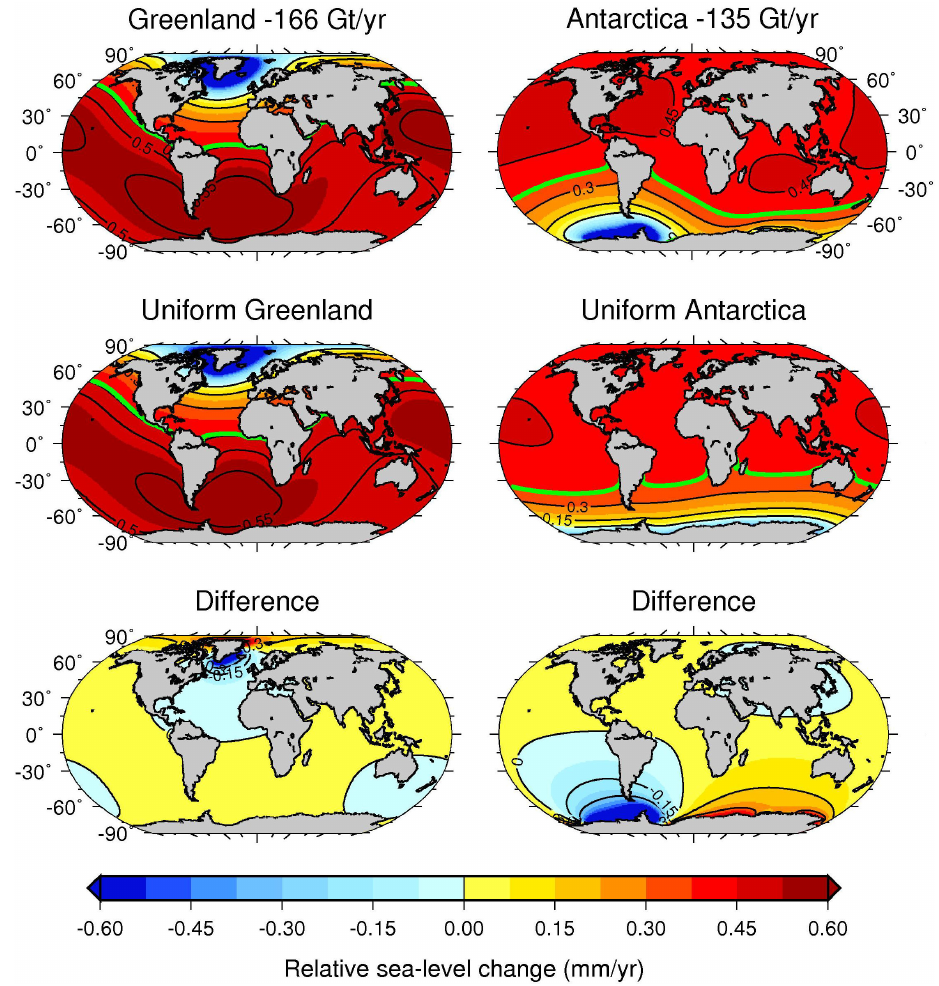
Fig. 3. Impact on relative sea level assuming uniform mass loss over Greenland, and the whole of Antarctica compared with the distribution shown in Fig. 1. The top panel is the same as Fig. 2a and b; the middle panel is for mass loss uniformly distributed across the ice mass and the bottom panel the difference between the two (observed-uniform).